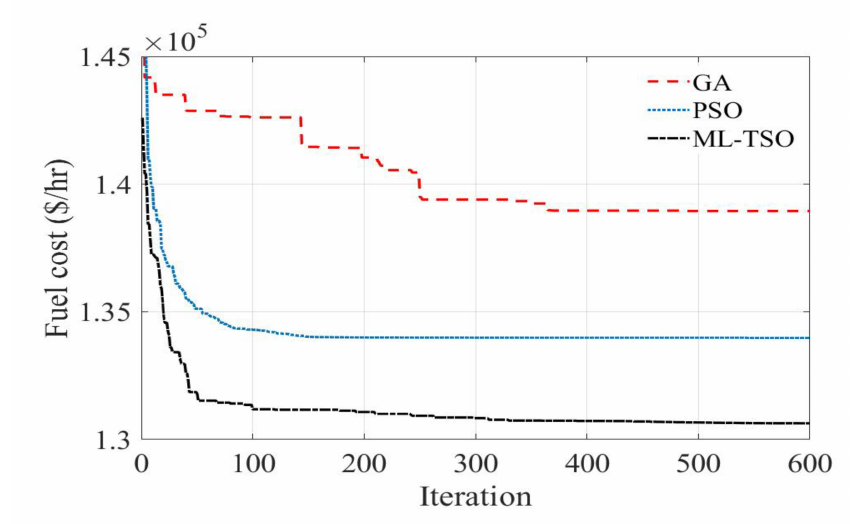
Figure 7. Cost function vs. iterations in the 118-bus system.